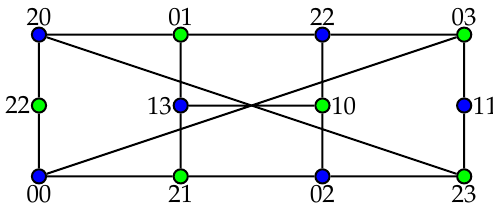
Figure 3. The 3-graph of G = Z 3 × Z 4